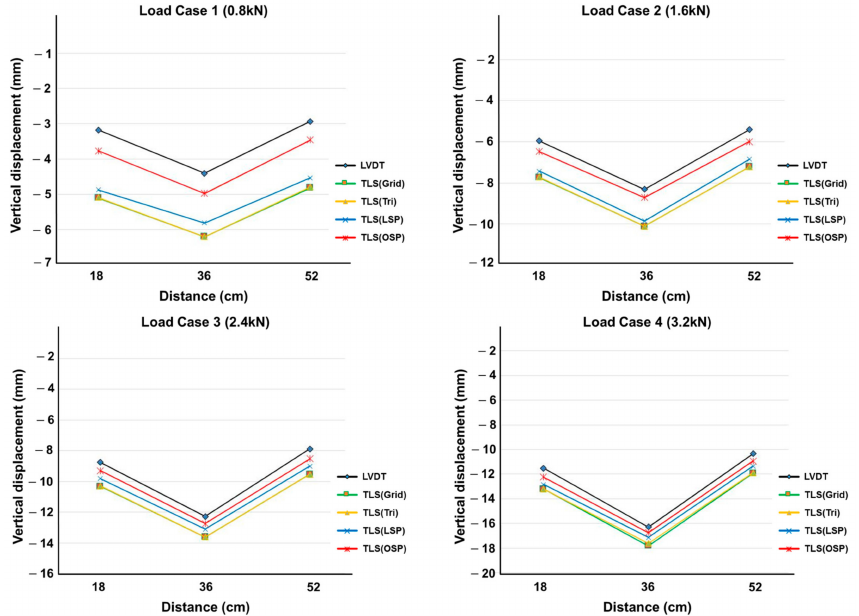
Figure 10. Comparison of vertical displacement between LVDT and the four methodologies (8 mm